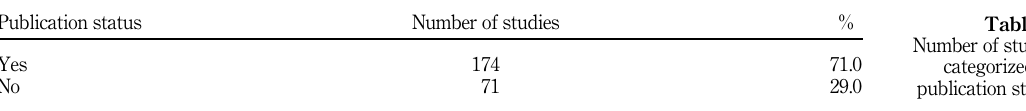
Table 1. Hypothesis testing on